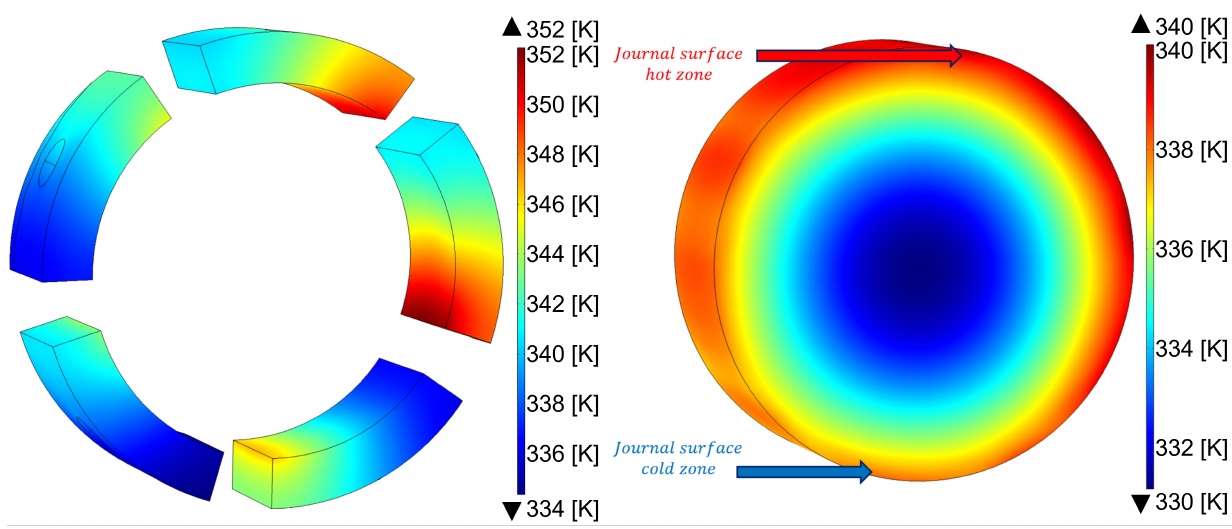
Figure 17. 3D representation of the temperature field of the Non-Drive End bearing pads and of the rotor fraction enclosed in the Non-Drive End bearing with a rotor rotational speed equal to 8000 rpm and an applied load equal to half of the rotor mass (LOP configuration) together with an unbalanced force.